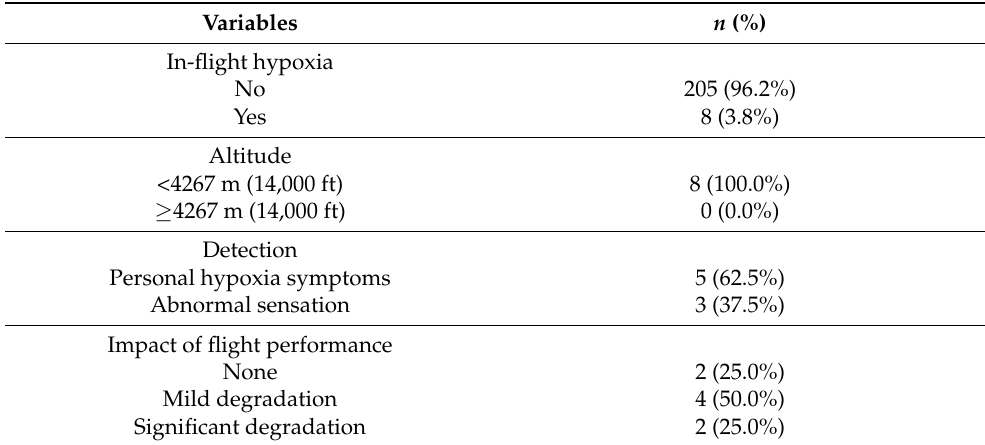
Table 4. Description of in-flight hypoxia events.